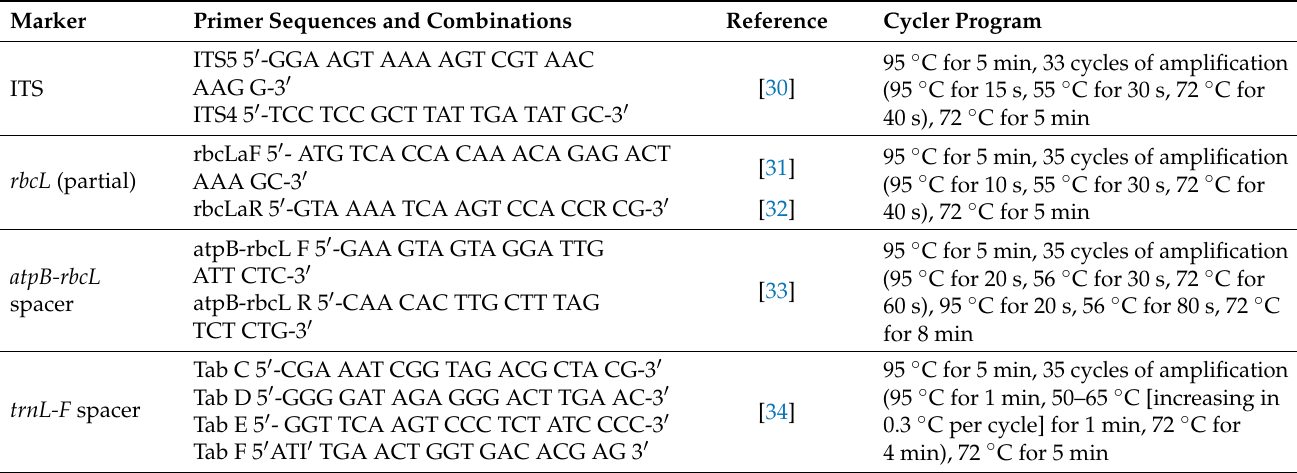
Table 2. Primers and cycler programs used for DNA